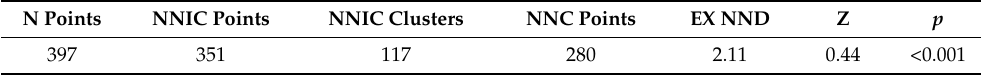
Figure 3. Examples of NNC using random points. Circles are classified as “noise”; triangles as “features”. Figure numbers indicate the number of the iteration (see Table S1). These iterations a re the same as Figure 2.